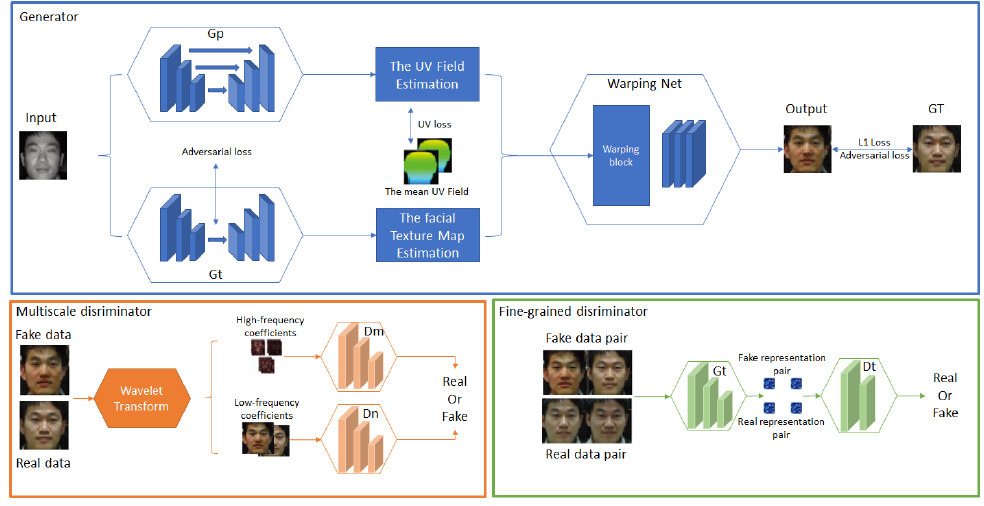
Figure 7. NIR-VIS face completion network based on